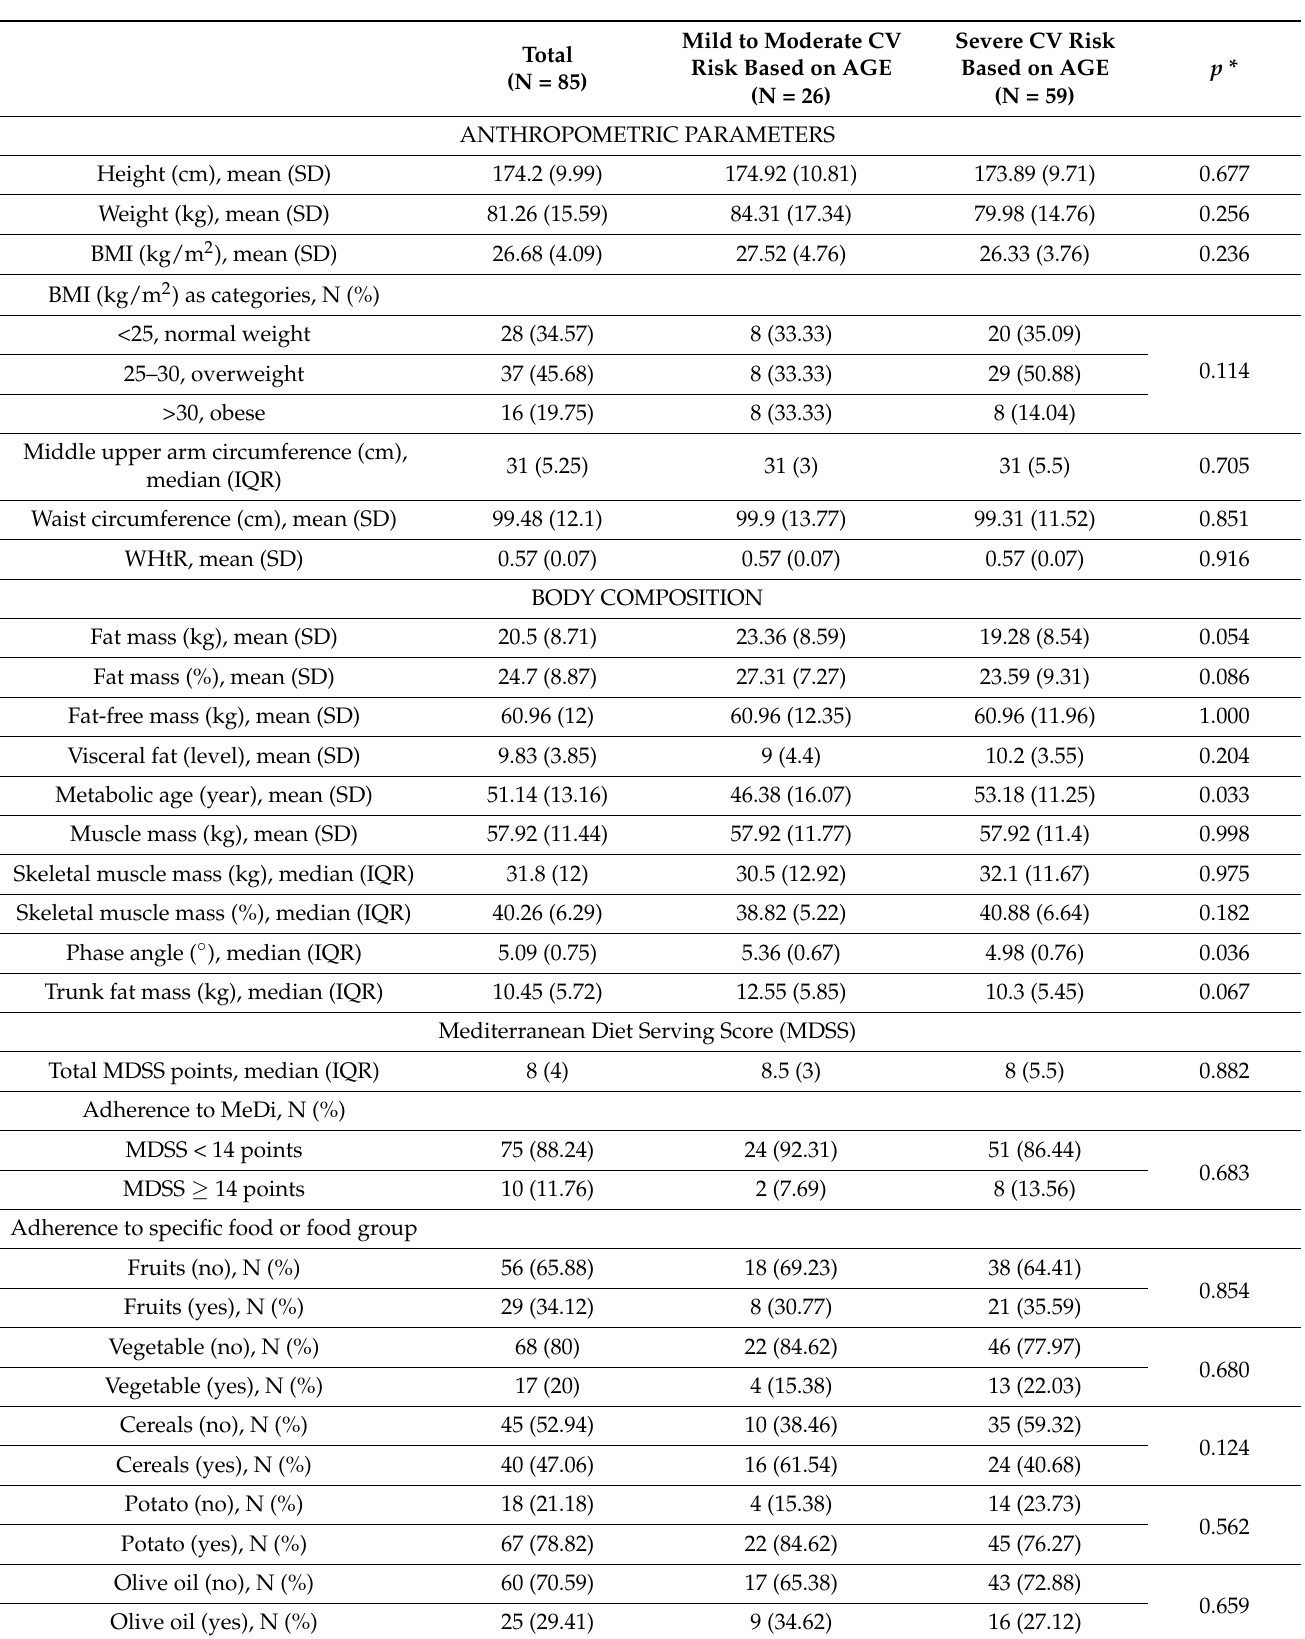
Table 2. Nutritional status and adherence to the Mediterranean diet of study participants and differences according to cardiovascular risk